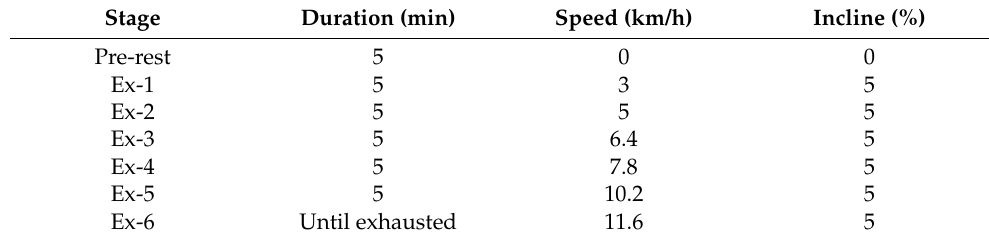
Table 2. Protocol of the modified Bruce treadmill